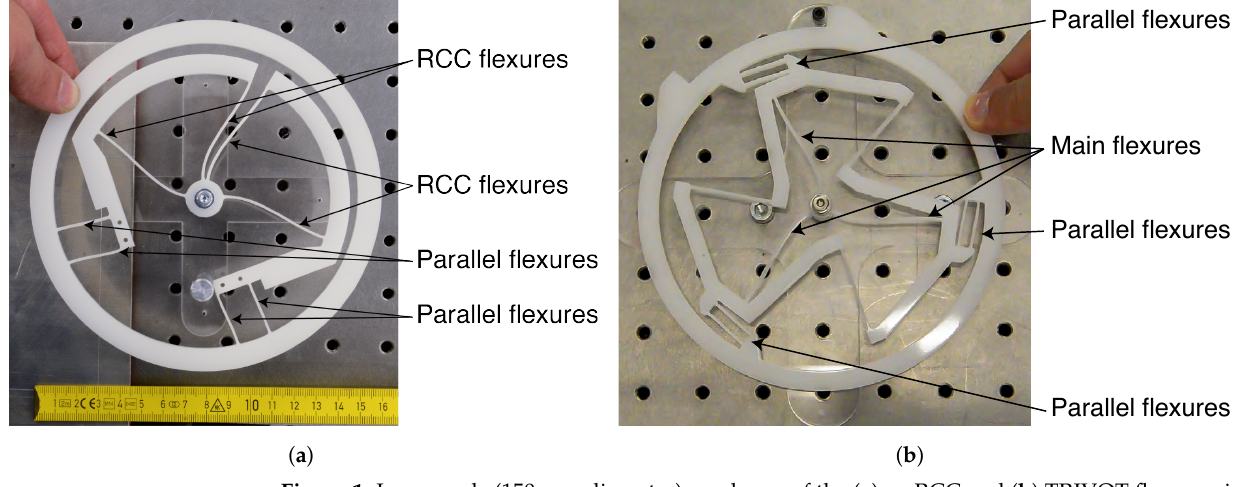
Figure 1. Large-scale (150 mm diameter) mock ups of the ( a ) co-RCC and ( b ) TRIVOT flexure-pivot oscillators fabricated by laser cutting a 5 mm thick Polyoxymethylene (POM) sheet. They are shown in rotated position (respectively, 26 and 22 degrees from equilibrium